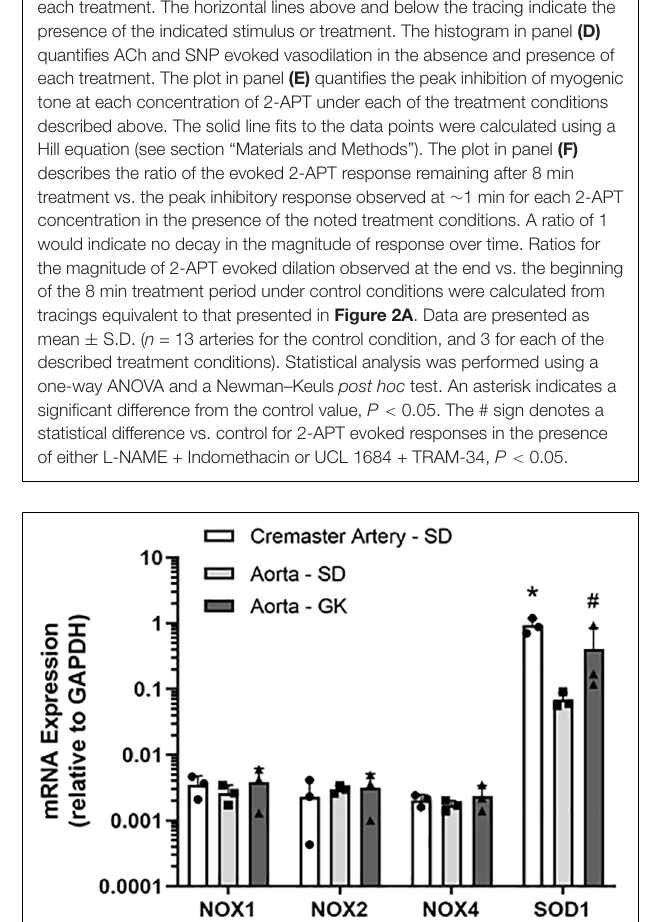
FIGURE 8 | Relative expression of mRNA encoding NADPH oxidase (NOX) isoforms in Sprague–Dawley (SD) and Goto-Kakizaki (GK) rat cremaster arteries and aorta. The expression levels of NOX1, 2 and 4 isoforms in each vessel type were quantified by qRT-PCR and are presented as ratios to the expression of GAPDH mRNA in the same vessel type. Measurements were performed in tissues from 3 individual animals. Statistical analysis was performed using a one-way ANOVA and a Newman–Keuls post hoc test. The asterisk denotes a statistically significant difference relative to SD aorta, P < 0.01; the # symbol indicates a difference vs. SD aorta; P < 0.05. Data are presented as means ±